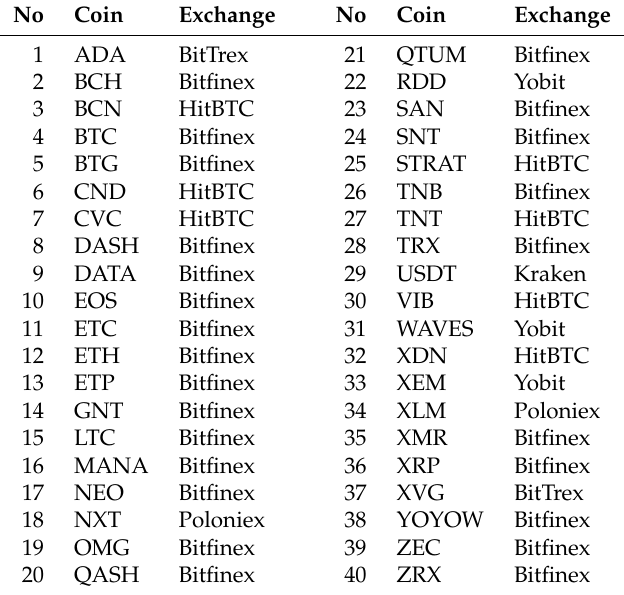
Table A1. Overview of coins and corresponding exchanges used throughout this study. Note: All coins are denominated in USD prices as provided by